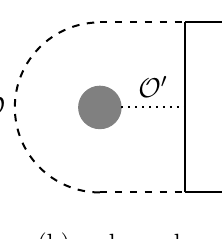
Figure 9. The t -channel diagram denotes a sum over the asymptotics (cid:14) ( O ) inverts to poles for the [ OOO 0 ] m families in the s -channel. When O 0 = 1 we omit the line by convention and recover (cid:12)gure